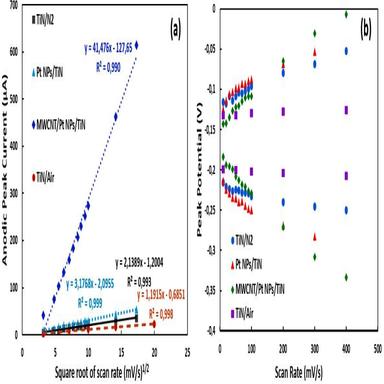
(a) The fitted Ipa versus the square root of the scan rates, (b) The cathodic and anodic peak potentials versus the scan rates. All in 0.1 M KCl solution containing 1 mM Ru (NH3)6 2+/3+.